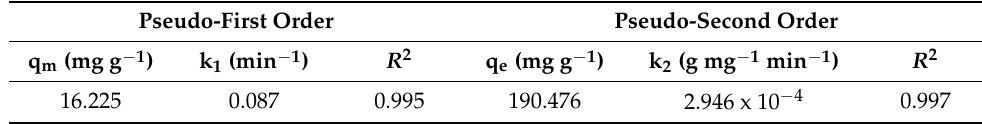
Table 2. Kinetic parameters for RO16 dye adsorption onto Cu(I)-PANI composite.